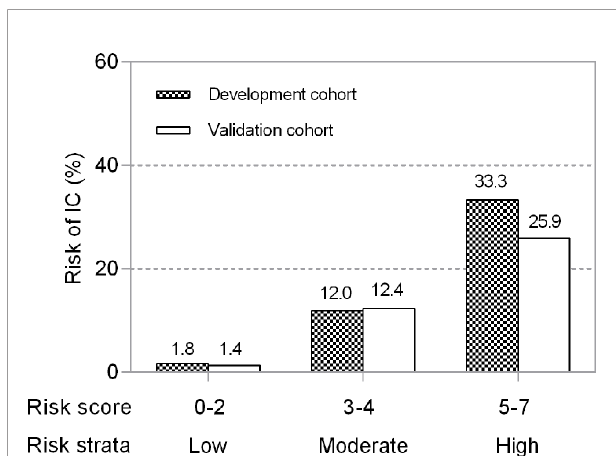
FIGURE 4 | Risk levels according to the risk score in development and validation cohorts. Risks were categorized into low risk (0 – 2 points), moderate risk (3 – 4 points) and high risk (5 – 7 points). Higher points denote a higher risk of developing IC in ICU patients (P for